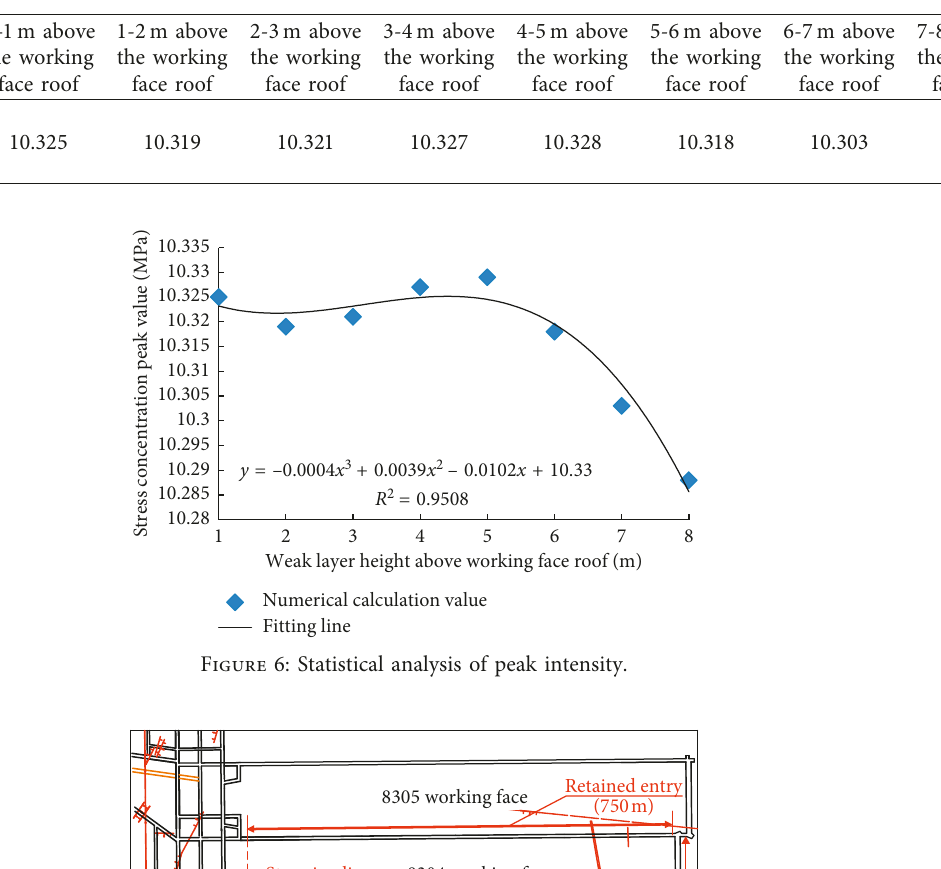
Table 2: Simulation results statistics.